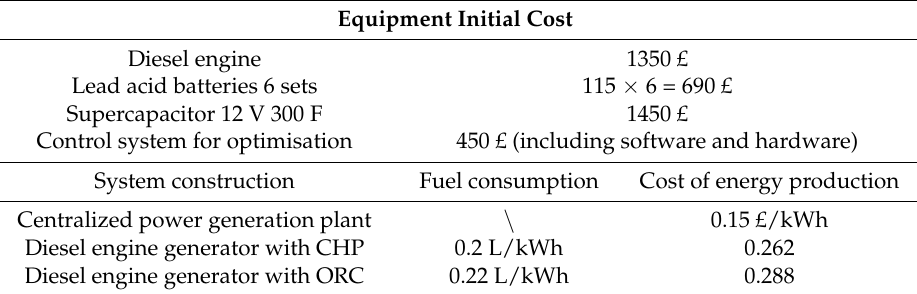
Table 3. Cost analysing of the